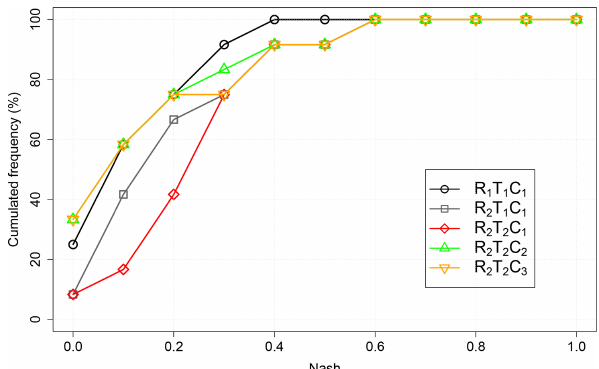
Figure 3. Cumulated frequency of the Nash values for each water- shed in zone A for each